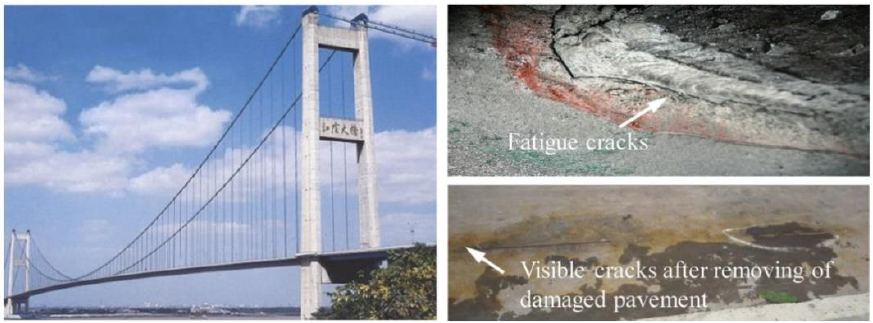
Figure 1. Fatigue cracks in the Jiangyin Yangtze River Bridge.